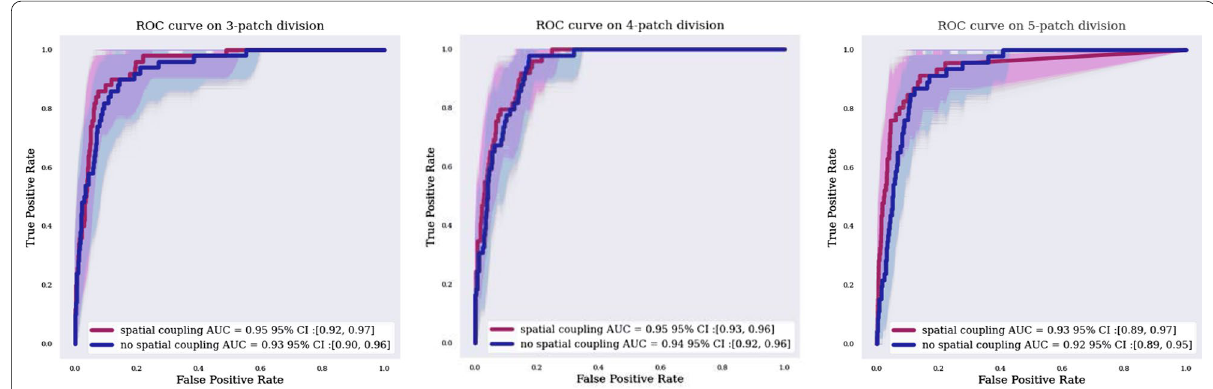
3 3 patches (3‑patch division, left), × ×